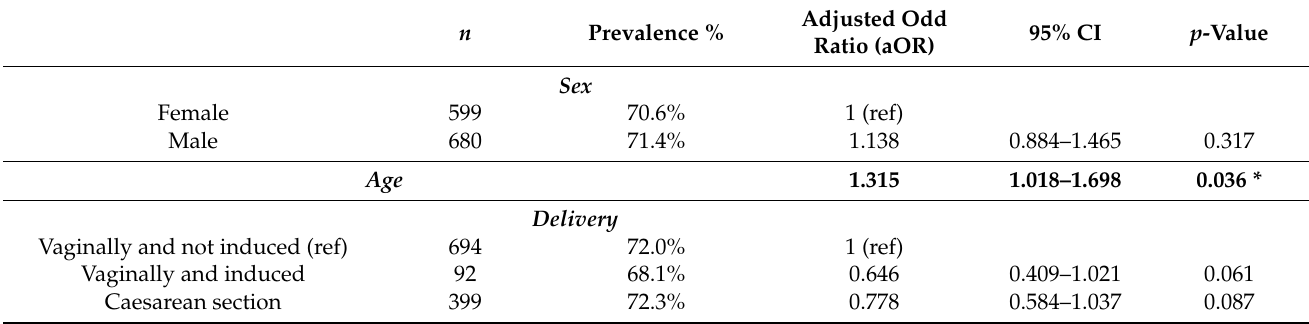
Table 3. Factors associated with uptake of additional